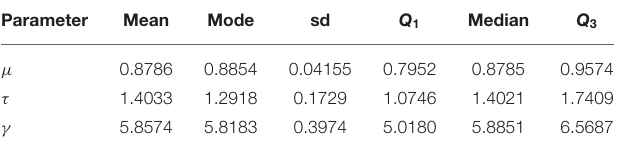
TABLE 2 | Bayes estimates of parameters based on scenario 1 with prior parameters µ 0 2, ζ 2, η 1, ξ 5, and σ 2 for the movement of blue = = = = = periwinkles dataset.